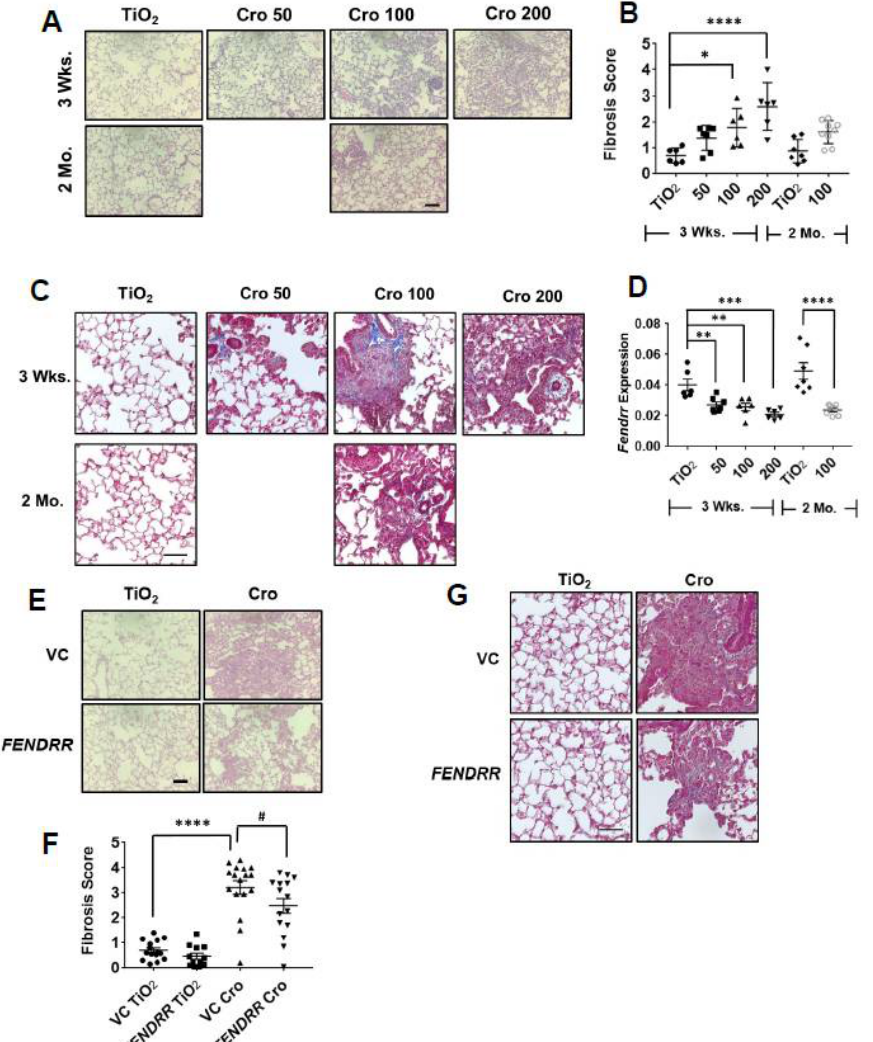
Figure 6. FENDRR reduces asbestos-induced lung fibrosis. ( A ) H & E staining of the lung tissues from the mice treated with different doses (50, 100, and 200 µg) of crocidolite asbestos (Cro) and collected at 3 weeks (wks) and 2 months (Mo). TiO 2 (100 µg) was used as a control. ( B ) Fibrosis scores as determined by the modified Ashcroft score in the lungs of mice treated with crocidolite. Mouse number and sex for each group: 3 Wks, TiO 2 = 6 (3F, 3M), Cro 50 = 7 (4F, 3M), Cro 100 = 6 (3F, 3M), Cro 200 = 6 (3F, 3M) and 2 Mo, TiO 2 = 7 (4F, 3M), Cro 100 = 9 (6F, 3M). ( C ) Trichrome staining of lung sections of mice treated with crocidolite. ( D ) Fendrr expression of asbestos-treated mice as determined by real-time PCR using Gapdh as a control. Mouse number and sex for each group: 3 Wks: TiO 2 = 6 (3F, 3M), Cro 50 = 7 (4F, 3M), Cro 100 = 6 (3F, 3M), Cro 200 = 6 (3F, 3M) and 2 Mo, TiO 2 = 7 (4F, 3M), Cro 100 = 9 (5F, 2M). ( E ) H & E staining of the lung sections from mice treated with virus control (VC) or FENDRR adenovirus and TiO 2 or crocidolite (200 µg). ( F ) Fibrosis scores as determined by the modified Ashcroft score in the lungs of mice treated with FENDRR adenovirus and crocidolite. Mouse number and sex: VC TiO2 = 15 (8F, 7M), FENDRR TiO2 = 12 (6F, 6M), VC Cro = 17 (9F, 8M) and FENDRR Cro = 15 (7F, 8M). ( G ) Trichrome staining of the lung sections of mice treated with FENDRR adenovirus and crocidolite. Scale bar: 100 µm for all sections. Values represent the means ± SE. * p < 0.05, ** p < 0.01 , *** p < 0.01 , **** p < 0.0001, # p < 0.05. One-way ANOVA and Bonferroni’s multiple comparison for (B). One-way ANOVA and Fisher’s LSD test for ( D, F ) .